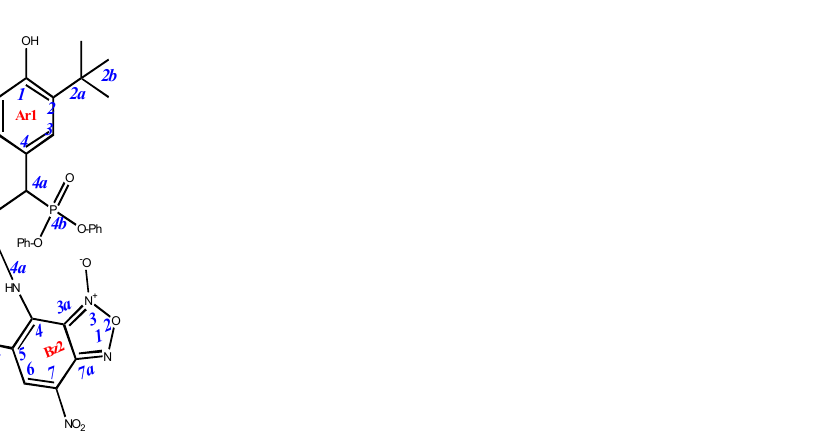
and 3.58 (d, J = 10.4 Hz, 6H, CH3) and 1.35 (s, 18H, H2b-Ar1). 13 C{ 1 H} NMR (DMSO- d 6 ,